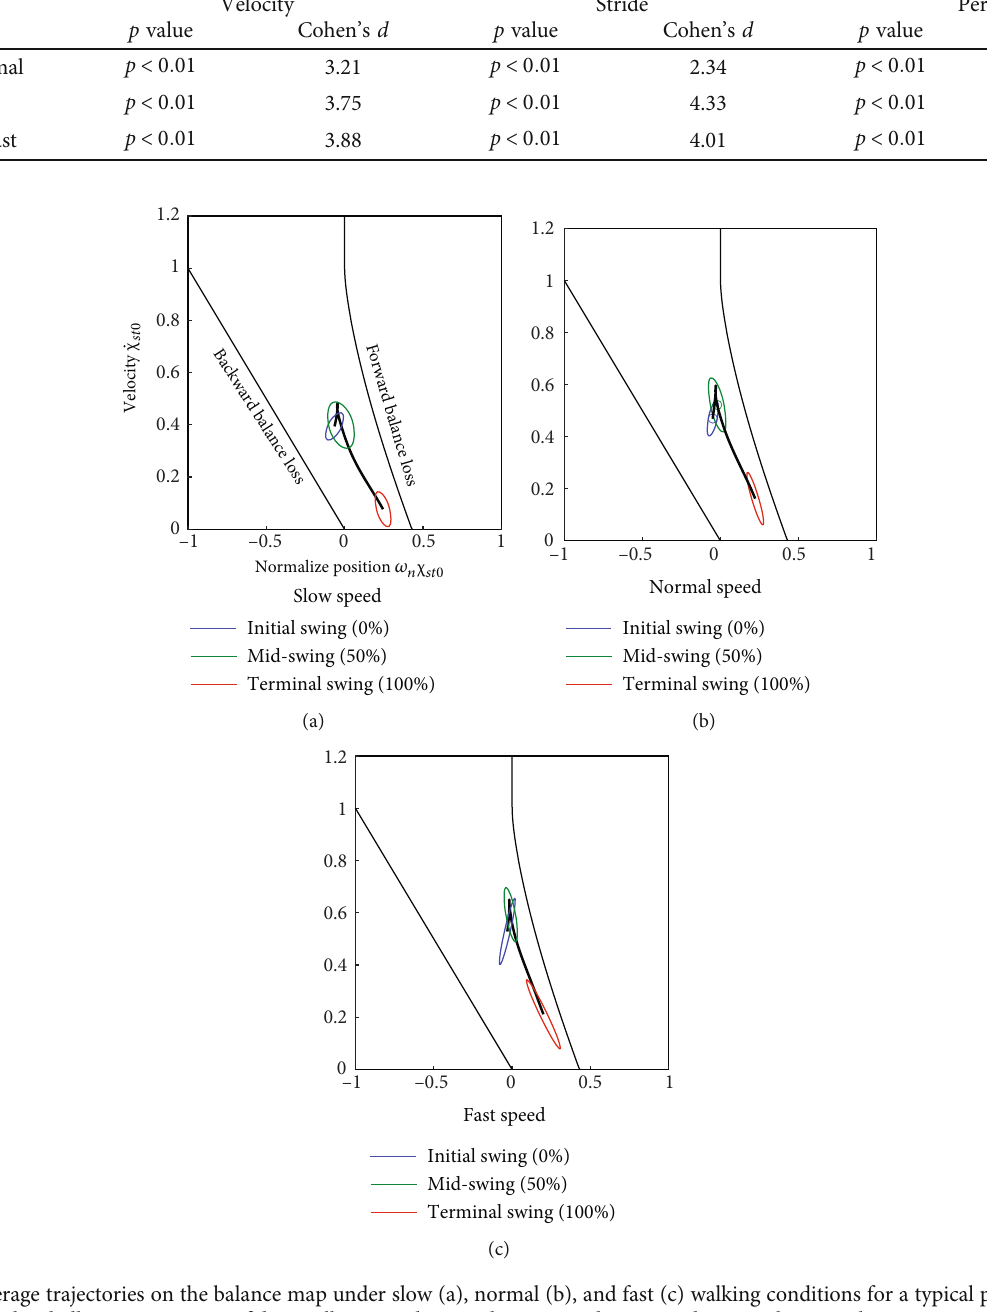
Figure 4: Average trajectories on the balance map under slow (a), normal (b), and fast (c) walking conditions for a typical participant. The blue, green, and red ellipses are 95% con fi dence ellipses at the initial swing, midswing, and terminal swing phases,